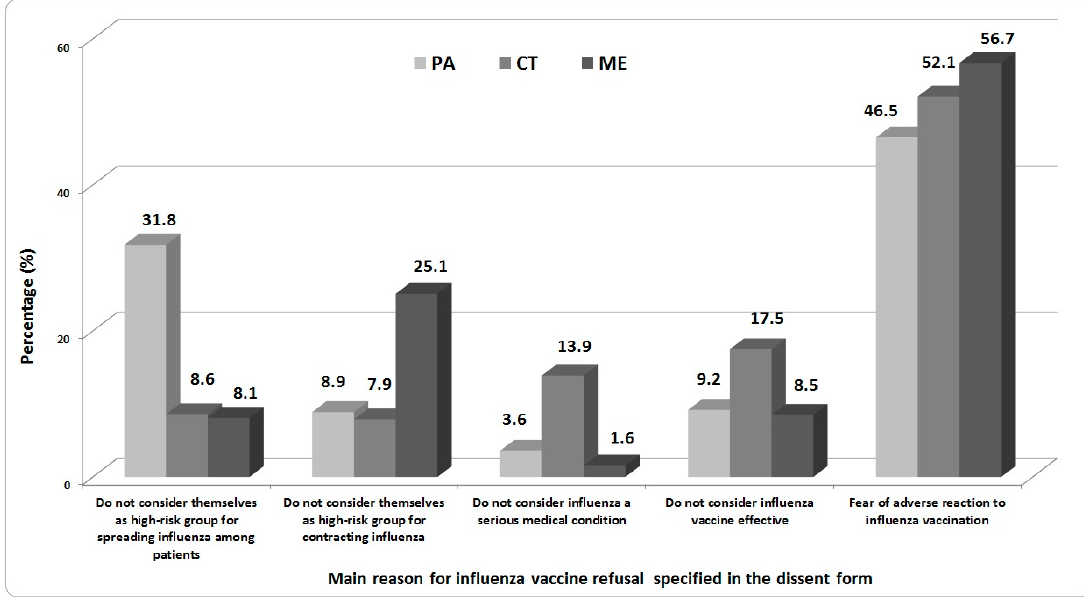
Figure 1. The main reasons for influenza vaccine refusal specified in the dissent form by HCWs (excluding students/trainees) at the Catania, Messina, and Palermo UHs. (Students and trainees did not fill in the dissent form, in accordance with the Sicilian Regional Decree.).